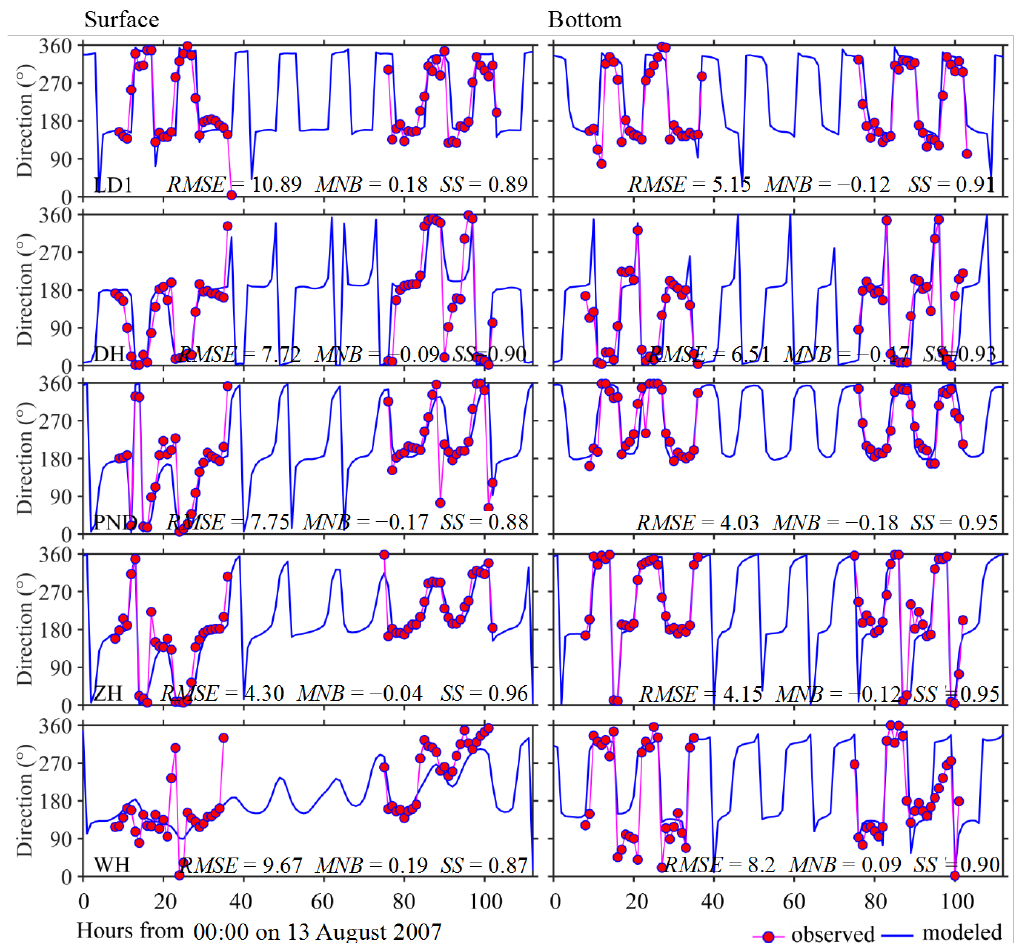
Figure 6. Comparisons of surface and bottom flow directions. The locations of the stations LD1, DH, PND, ZH and WH are shown in Figure 2 by black dots.